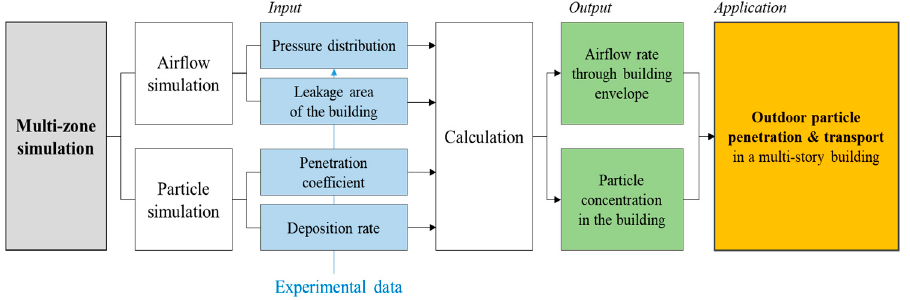
Figure 3. Conceptual diagram of multi-zone simulation modeling.